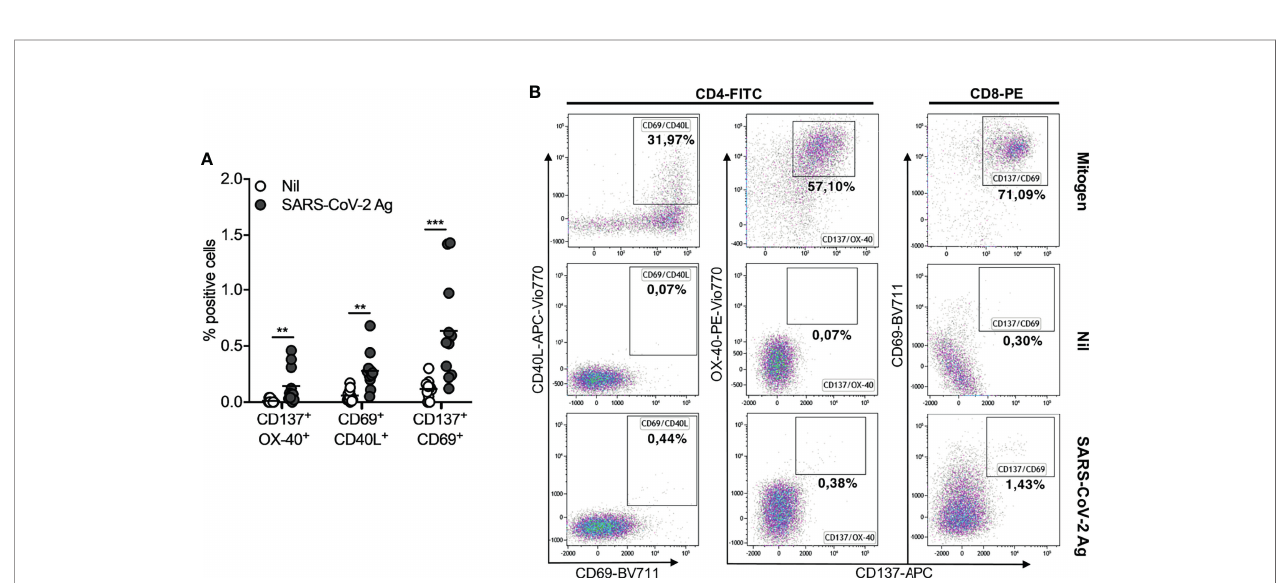
FIGURE 4 | Activation-induced memory (AIM)-T cell detection in seronegative recipients (ICs n=11) of P fi zer-BioNTech BNT162b2 mRNA-based vaccination at T3. (A) Comparing of percentage (%) of AIM-T cells in Nil tubes to SARS-CoV-2 antigen using speci fi c marker CD137/OX-40, CD69/CD40L, CD137/CD69 (CD40L is uniquely expressed on activated CD4 T cells; CD69 is an activation marker of both CD4 and CD8 T cells; CD137 and OX-40, both belonging to the TNF receptor superfamily, are also markers of Ag-speci fi c CD8 and CD4 T cells, respectively. In combinations, CD137/OX-40 and CD69/CD40L identify Ag-speci fi c CD4 T cells, while CD137/CD69 identi fi es Ag-speci fi c CD8 T cells). (B) Representative fl ow cytometry plots (one subject) showing AIM-T cell subpopulations stimulated or not (Nil) with SARS-CoV-2 antigen and the positive control (Mitogen). The signi fi cance was determined using Wilcoxon matched-pairs test, **p = 0.0021; ***p = 0.0002.